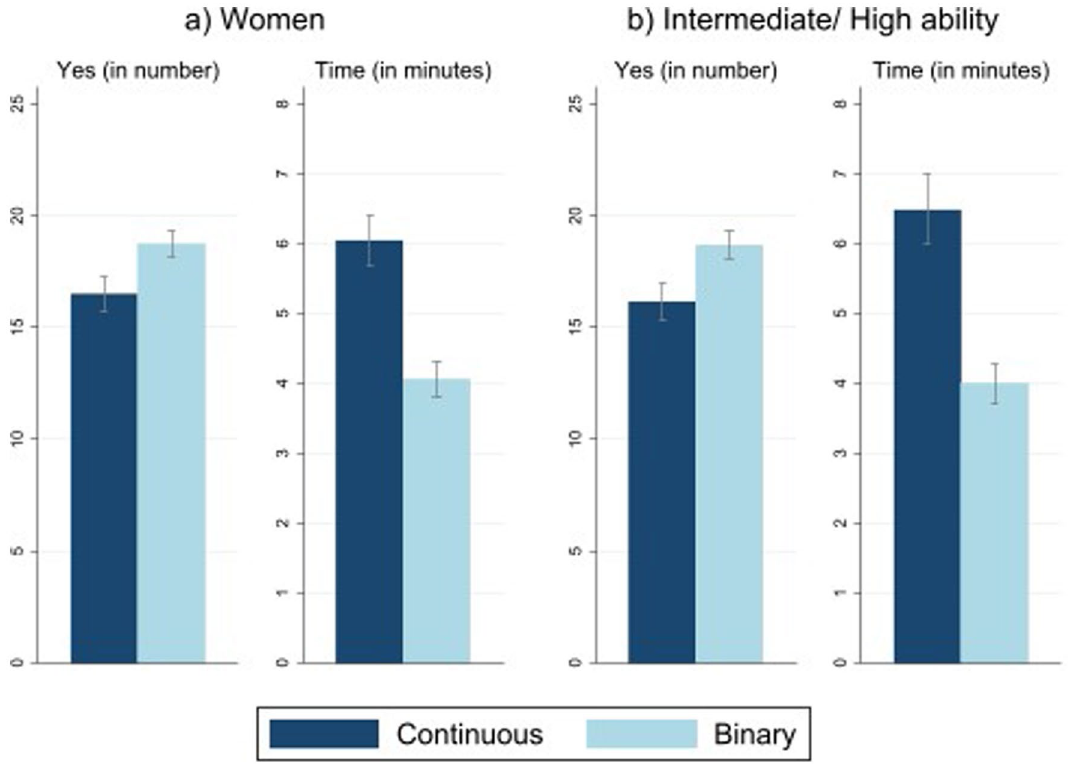
Figure 3. Binary vs. continuous settings. Left: average number of times the subjects agree in the questionnaire. Right: response time in minutes. ( a ) Women, ( b ) Intermediate/high ability. Lines with caps represent 95%